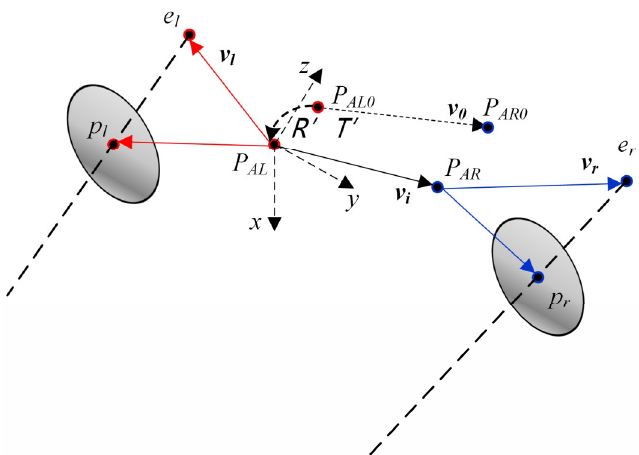
Figure 8. The origin of the eye coordinate system is built as shown in the figure; the axis direction and the scale factor are consistent with the device coordinate system. When the head posture changes, the eyeball center coordinates could be changed when compared with the calibration results. Therefore, the inner eye corner vector needs to be used as the reference to use the calibrated 3D eyeball model parameters when using the gaze tracking system.